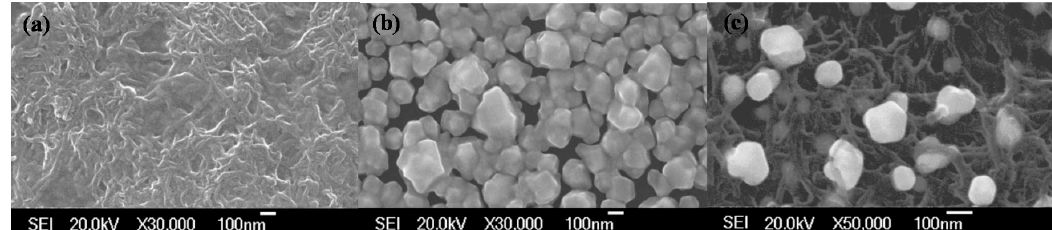
Figure 6. ( a ) FE-SEM of the CNTs; ( b ) Au nanoparticles on GCE; and ( c ) Au nanoparticles combined with CNTs on GCE. (Reproduced with permission of Springer from [42]).